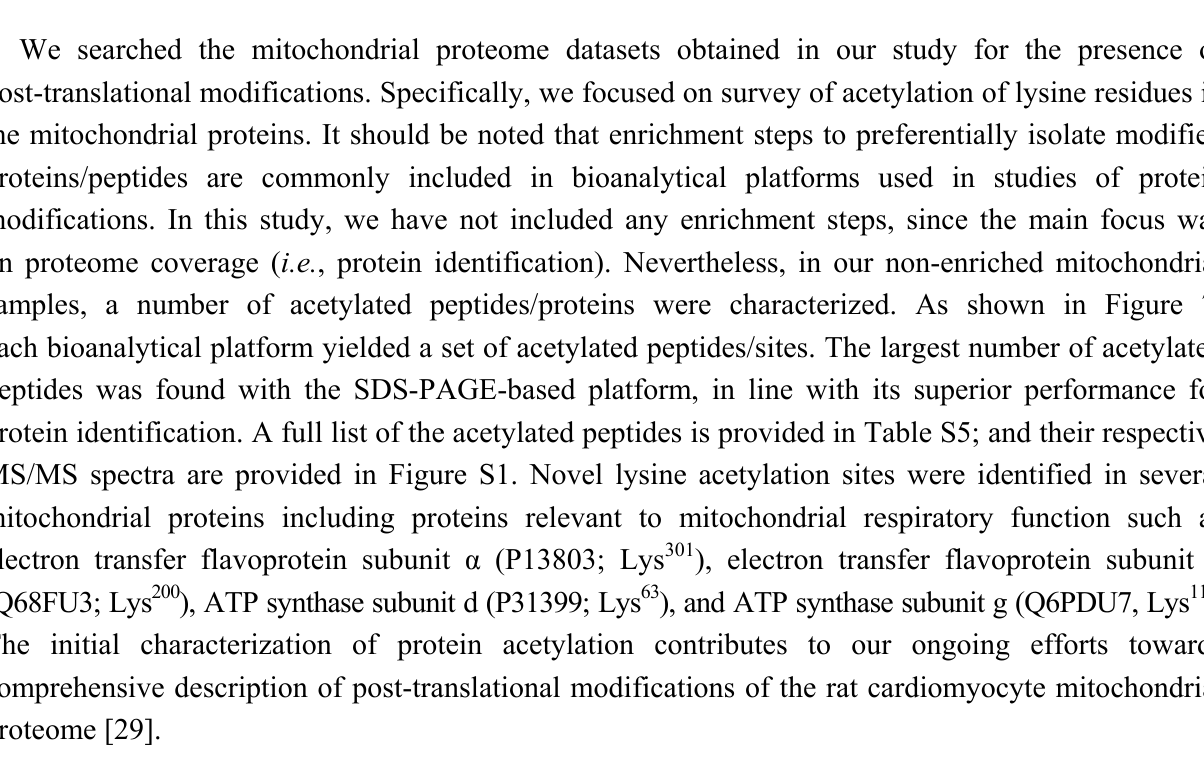
Figure 7. Characterization of protein acetylation in the mitochondrial proteome. The Venn diagram indicates the number of acetylated peptides characterized with each